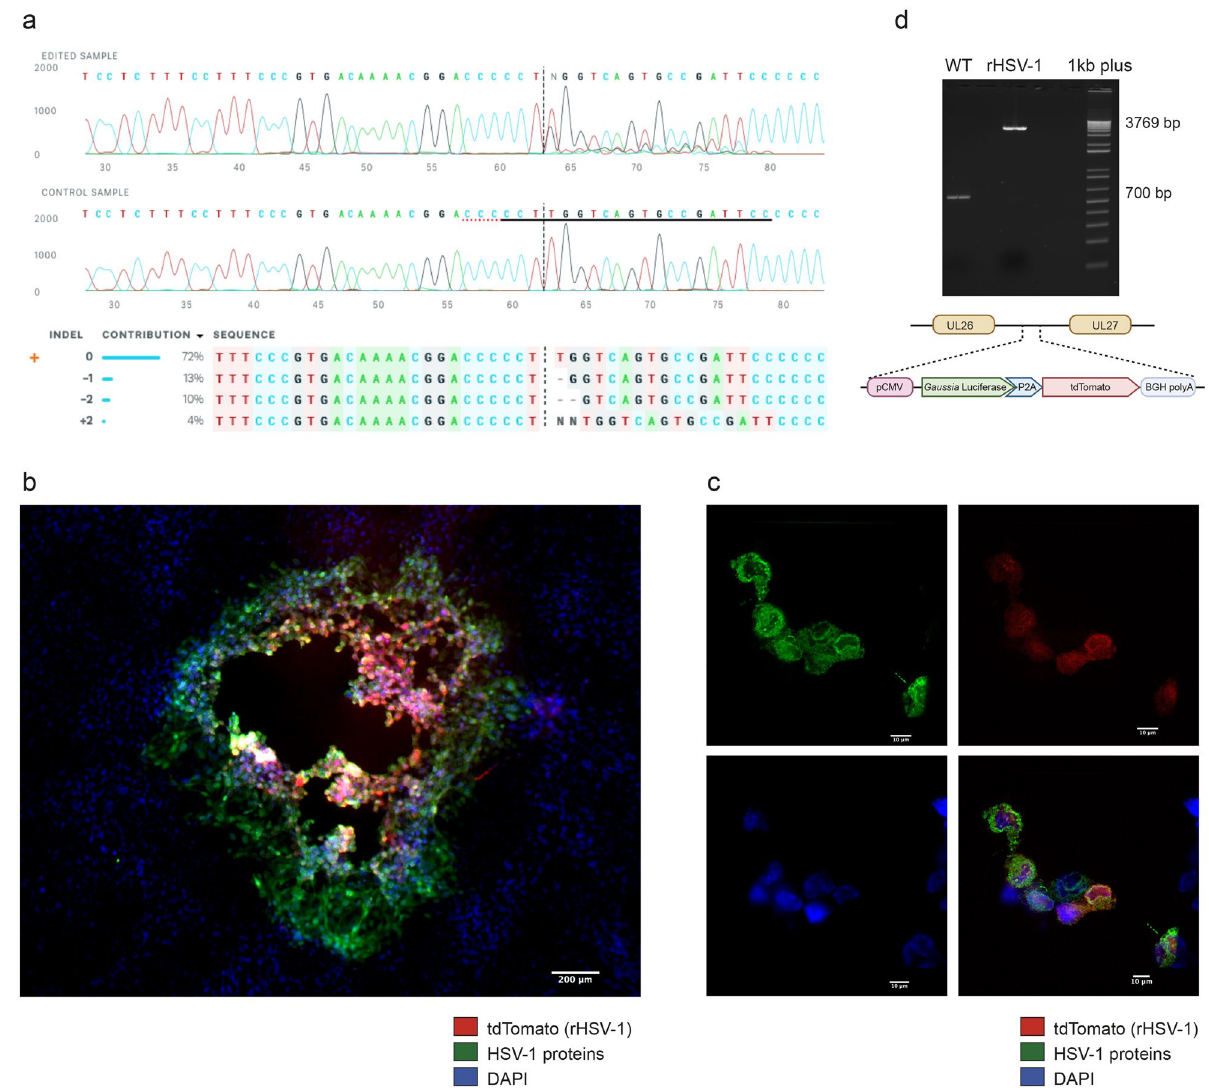
Figure 2. rHSV-1 production, isolation, and validation process ( a ) Validation of gRNA-2 targeting UL26-UL27 intergenic region. Sanger sequencing chromatograms of UL26-UL27 PCR amplicons from edited samples containing WT and recombinant HSV-1 show heterozygous peaks between 64 and 80th nucleotides that correspond to NHEJ-mediated indel introduction after gRNA-2 guided Cas9 cut (top). The horizontal black and red dotted-underlined regions represent gRNA and PAM sequences, respectively. Example of Inference of CRISPR Edits’ (ICE) analysis on a gRNA-2-edited viral clone showing indel mutations in UL26-UL27 intergenic region of HSV-1 (bottom). The contributions show the inferred sequences present in the edited population and their relative proportions. Black vertical dashed lines represent cut sites (top and bottom) and the WT sequence is indicated with a “+” on the left. ( b ) The isolation of rHSV-1 was confirmed by immunostaining analysis of infected Vero cells for rHSV-1. Immunofluorescence analysis of infectious spots (scale bar: 10 μm, magnification 5X) showed that all infectious spots were tdTomato + (red) and HSV-1 + (green). ( c ) Confirmation of tdTomato expression by rHSV-1 + Vero cells. tdTomato expression (red) was confirmed by confocal imaging of infected Vero cells labeled with HSV-1 proteins (green) and counterstained with DAPI (blue) (scale bar: 10 μm, magnification 100 ×). Following the selection process of rHSV-1, Vero cells on cover slips were infected with rHSV-1, then washed, fixed, permeabilized, blocked and immunostained. ( d ) Confirmation (top) and schematic presentation of the incorporation of exogenous fragment (bottom) into UL26-UL27 intergenic region. Agarose gel electrophoresis of PCR products obtained from the UL26-UL27 intergenic region amplification of WT HSV-1 (700 bp) and rHSV-1 (3796